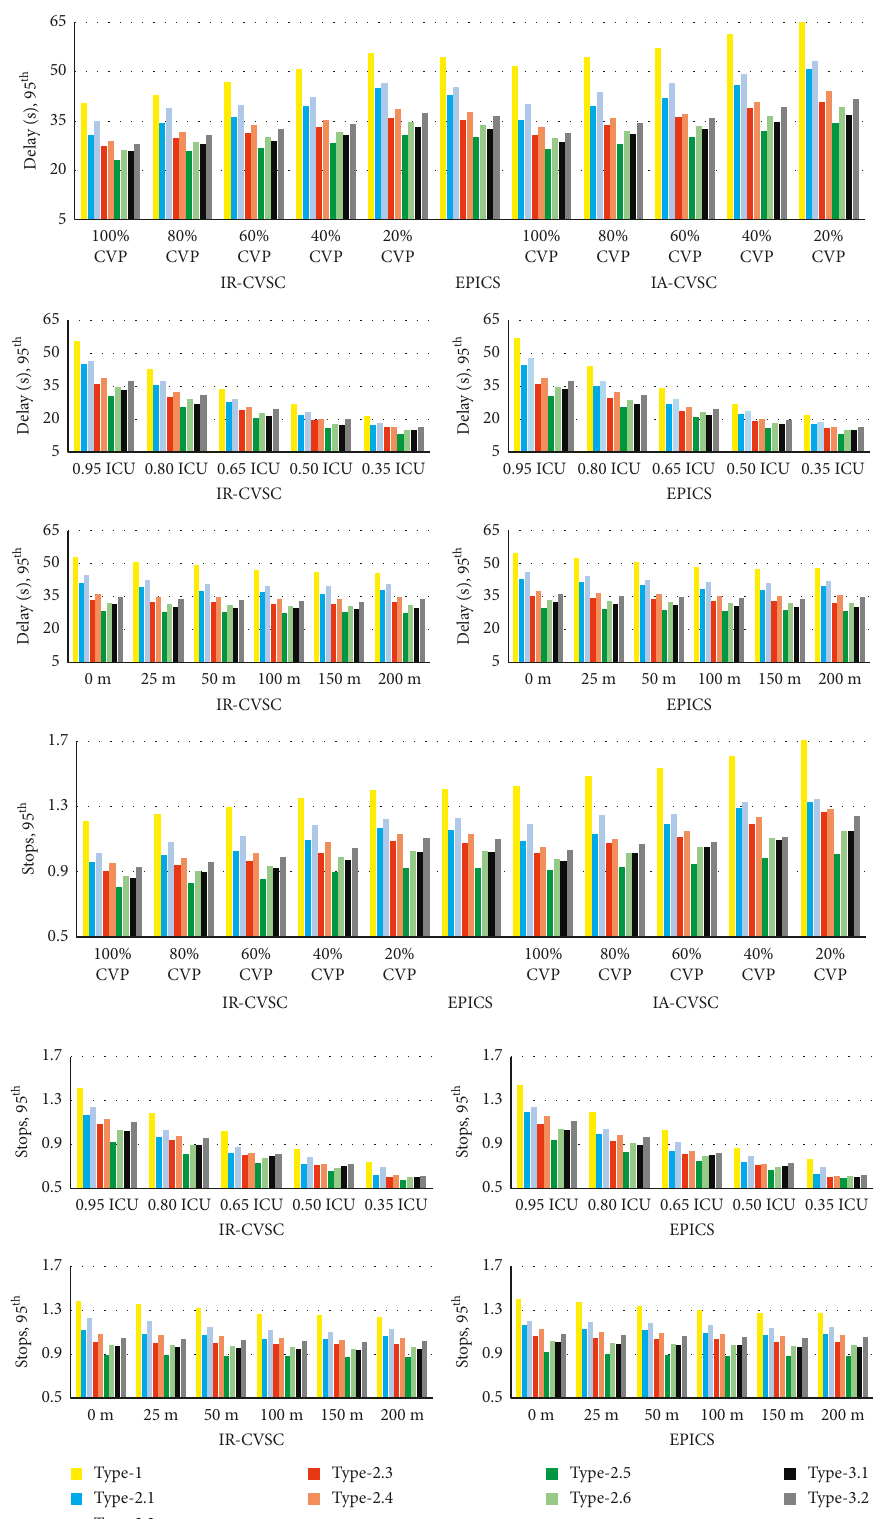
Figure 8: Signal control MOEs of IR-CVSC, IA-CVSC, and EPICS strategies of all incidents. Each bar represents the MOE of an incident